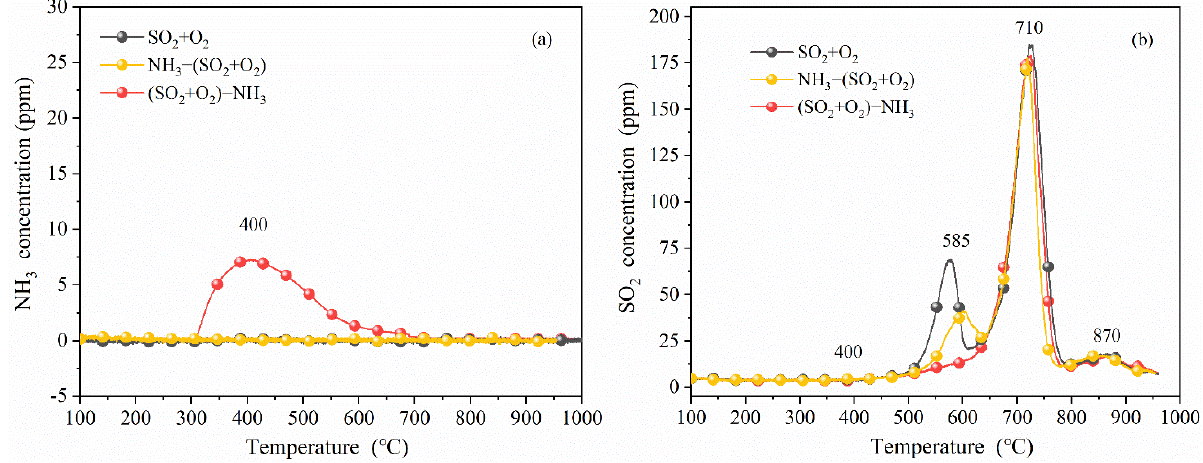
Figure 3. TPD curves of ( a ) NH 3 and ( b ) SO 2 over the catalyst that was pretreated in SO 2 + O 2 and NH 3 in different sequences.